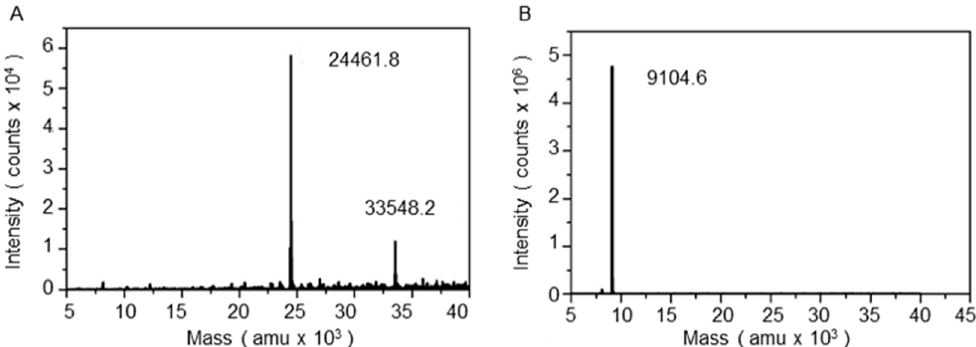
Figure 3. LC-MS characterization of the OmpT samples: ( A ) The larger autoproteolyzed fragment (24.4 kDa) and intact OmpT (33.5 kDa) after detergent removal via methanol/chloroform/water precipitation, and ( B ) the smaller proteolyzed fragment (9.1 kDa) from the soluble phase (i.e., without precipitation).